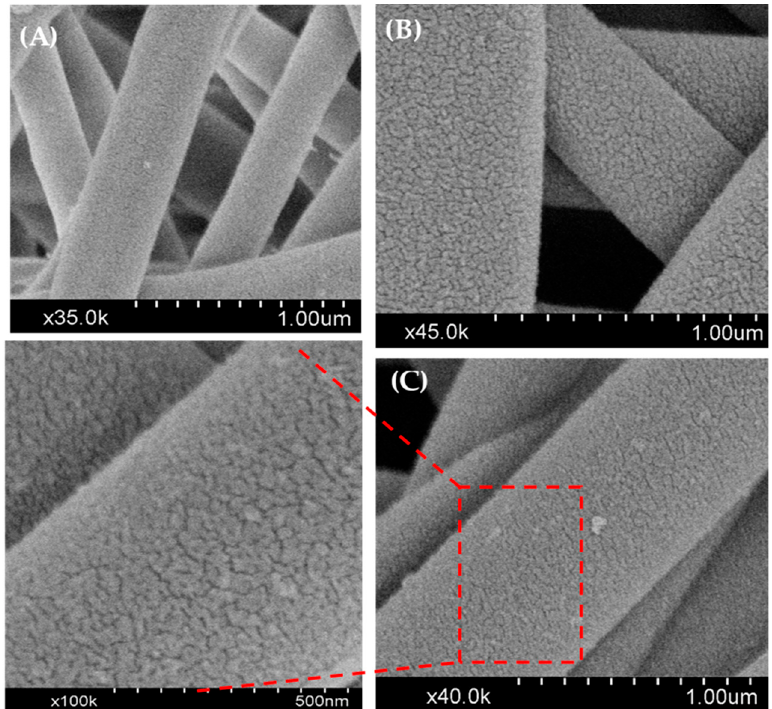
Figure 3. SEM images of PA6-NFsM ( A ) and PPy-PA6-NFsM before ( B ) and after ( C ) extraction of β -lactam antibiotics.